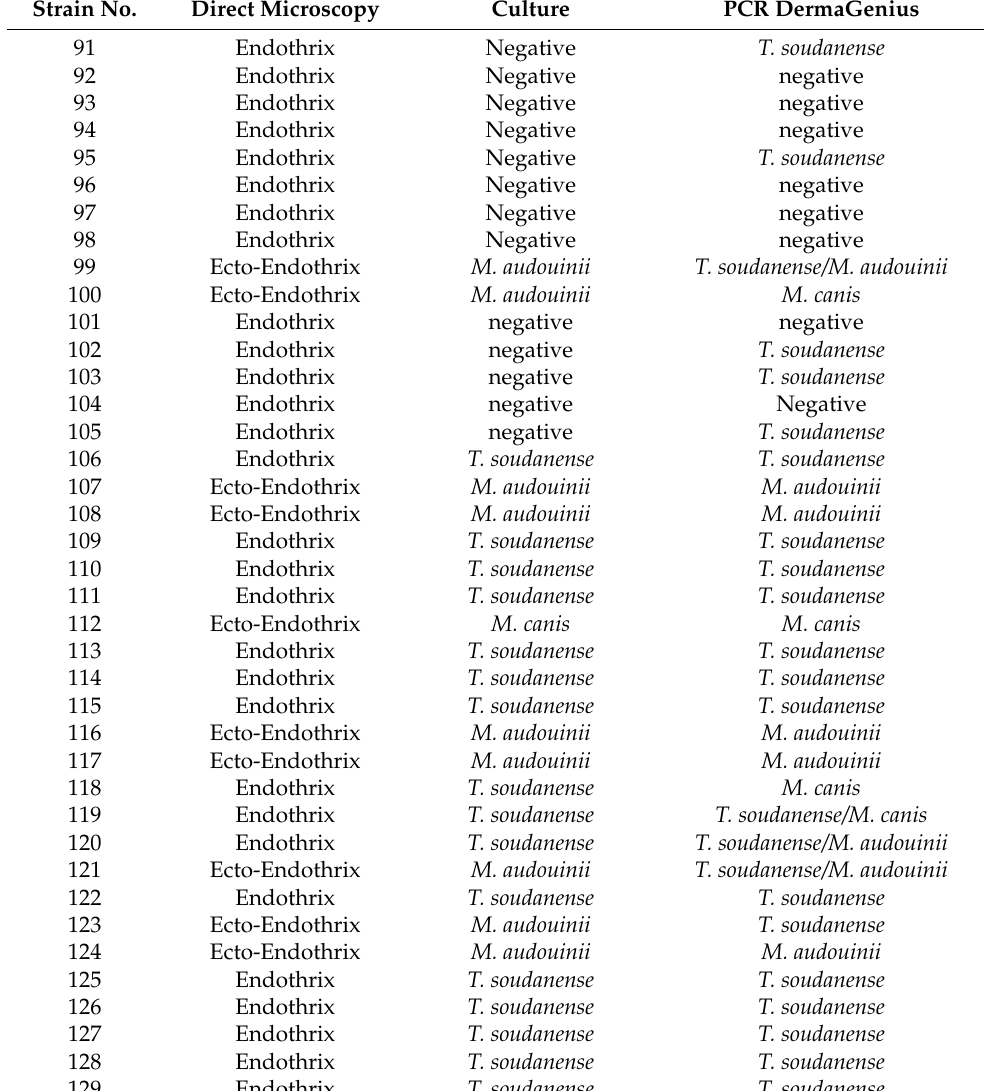
Table 1. Cont. Strain No.